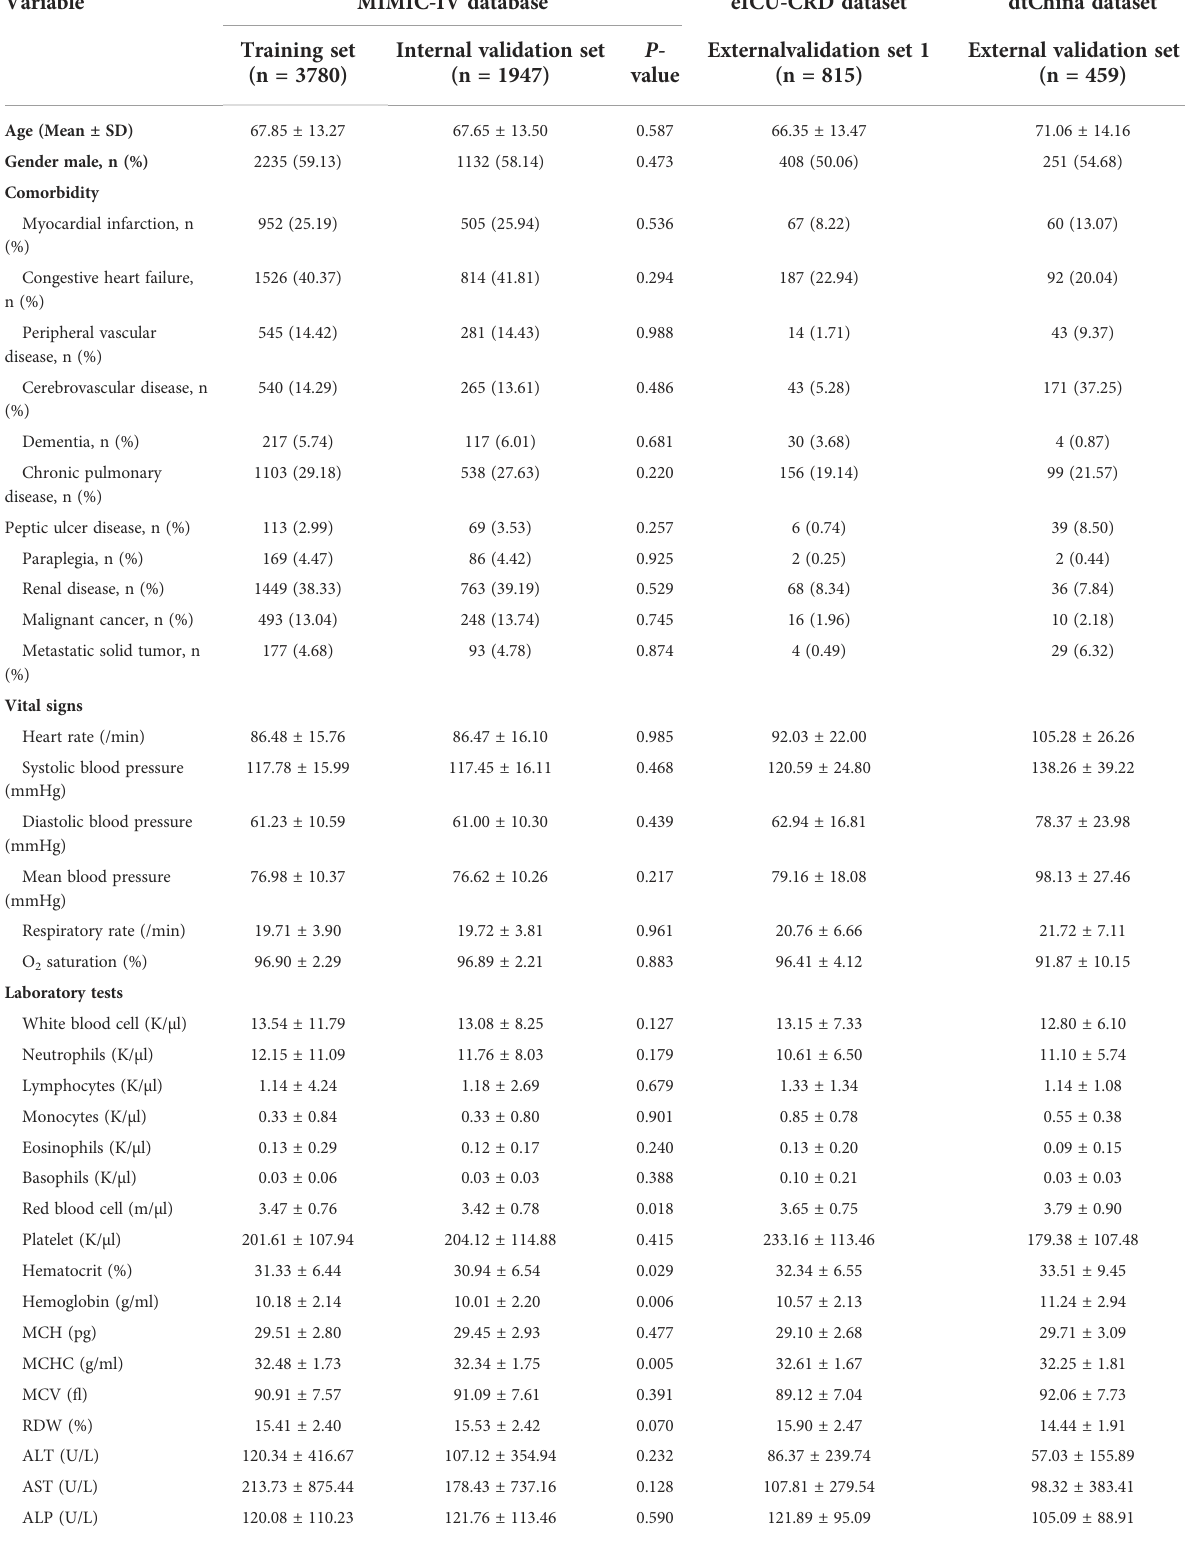
TABLE 1 Baseline characteristics, clinical tests, interventions, and outcomes of the study